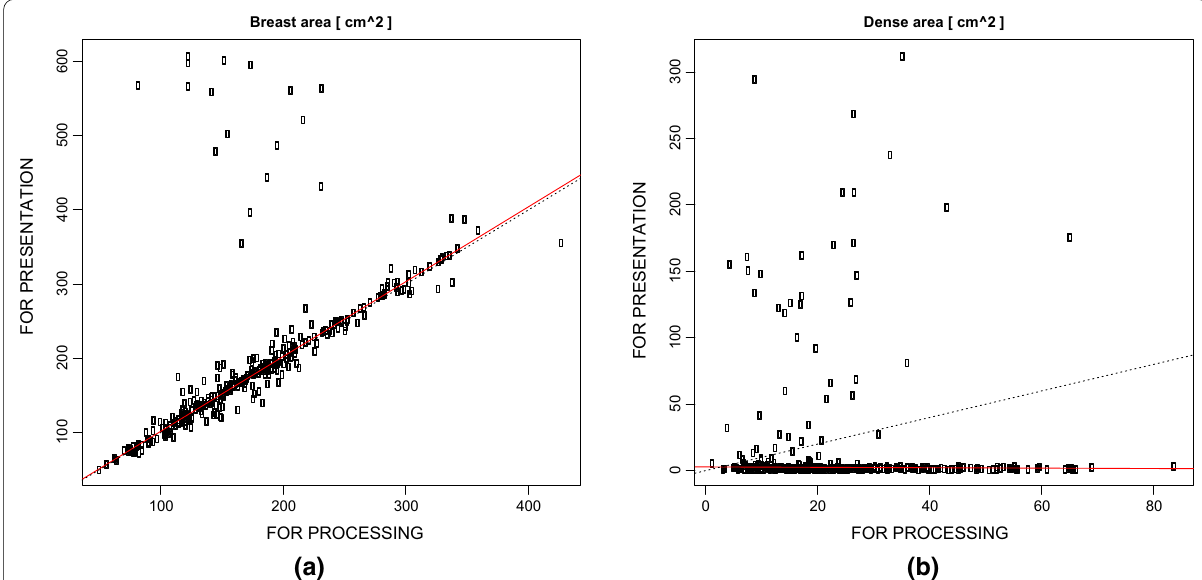
Fig. 2 Bland–Altman analysis of ( a ) breast and ( b ) dense area (cm 2 ) segmented with LIBRA on FOR PROCESSING and on FOR PRESENTATION images. Each marker represents an image. Robust linear fitting is reported in red (solid); identity line is dotted for reference. Spearman’s rank correlation index is ( a ) 0.88, ( b ) 0.16 ( p < 0.001). While a strong correlation exists betweeen breast areas, the negative correlation coefficient for dense area can − be understood by the example in Fig. 1: often the dense area segmented on FOR PRESENTATION images is very small compared to the dense area segmented from FOR